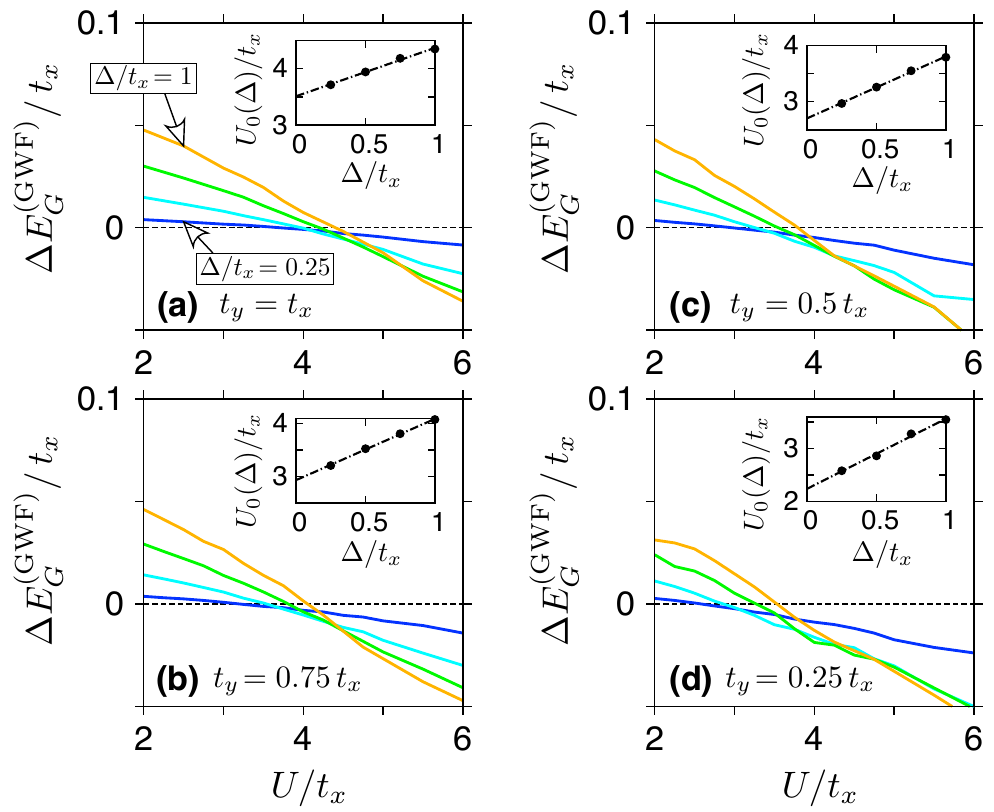
Figure 3. ( a – d ) Main: Energy difference between the antiferromagnetic Gutzwiller variational ( m ) [see Equation (13)] and the paramagnetic solution E ( GWF ) energy E ( GWF ) G simulations as a function the on-site Hubbard repulsion ( U ). The parameter η is optimized for a fixed m = ∆ / U (or m = 0); ∆ is varied between the lines from ∆ / t x = 0.25 to ∆ / t x = 1, with the steps of 0.25. The hopping anisotropy t y / t x is varied between the panels. Inset shows the value of U = U 0 ( ∆ ) at which ∆ E ( GWF ) changes sign for a given ∆ . The extrapolation to ∆ G U ( GWF ) c given in Table 1. (Statistical errorbars are too small to be shown on the